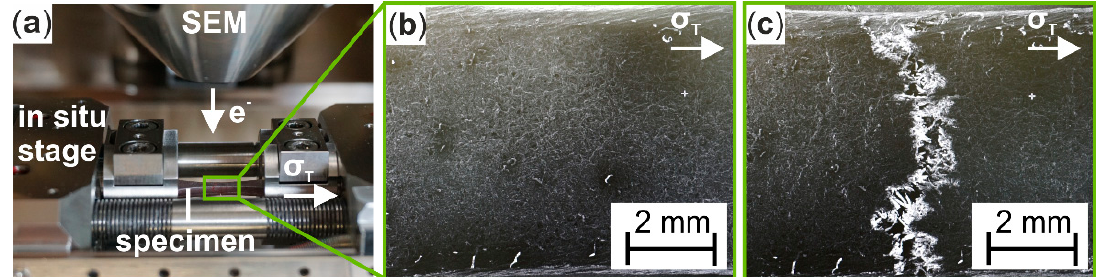
Figure 2. In situ tensile test in SEM: ( a ) integrated micro-tension module (Kammrath & Weiss GmbH, Dortmund, Germany) with mounted Cottonid specimen; SEM micrographs of gauge length’s surface ( b ) in initial condition; and ( c ) after failure .